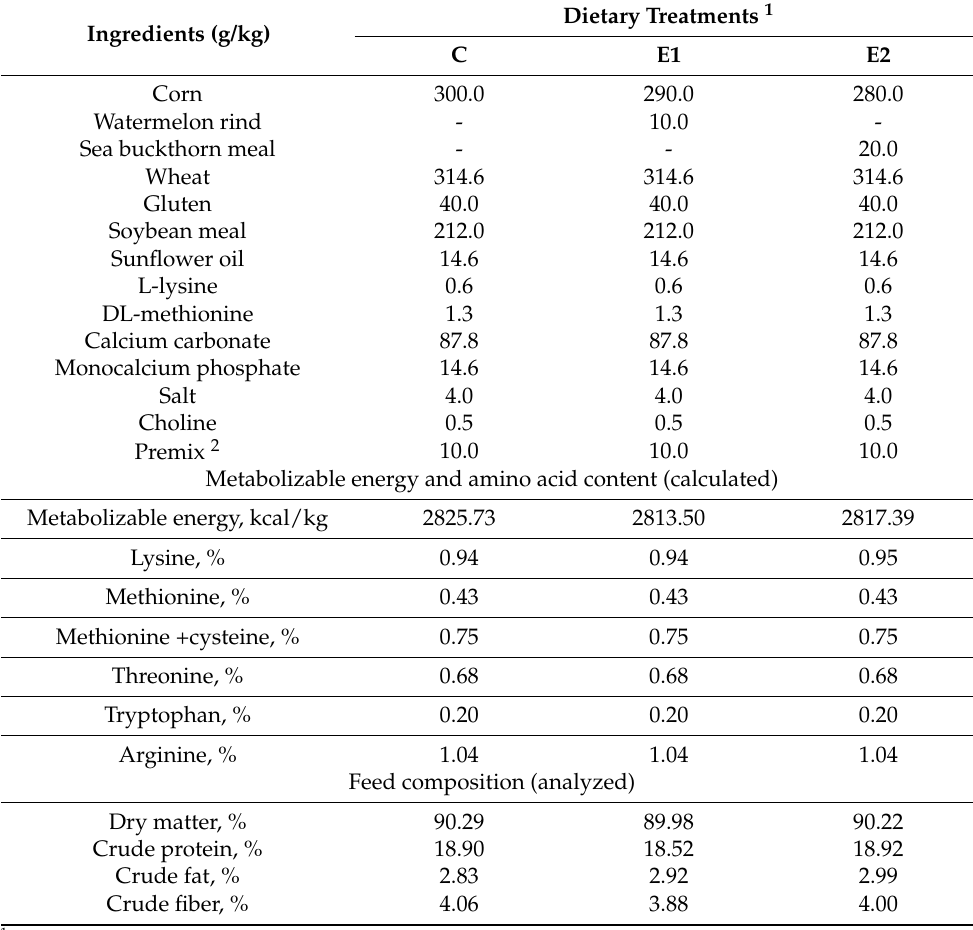
Table 1. Diet formulation and chemical composition of the